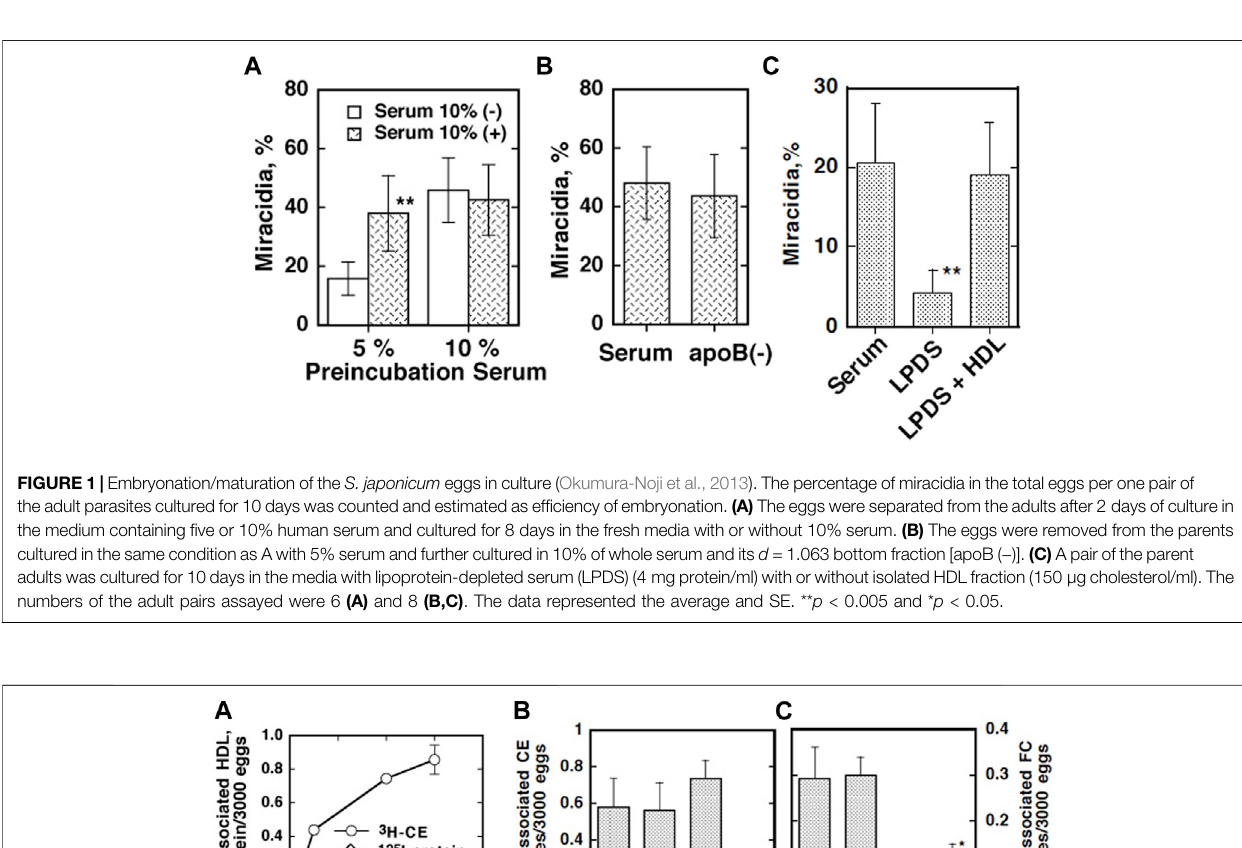
Frontiers in Cell and Developmental Biology |